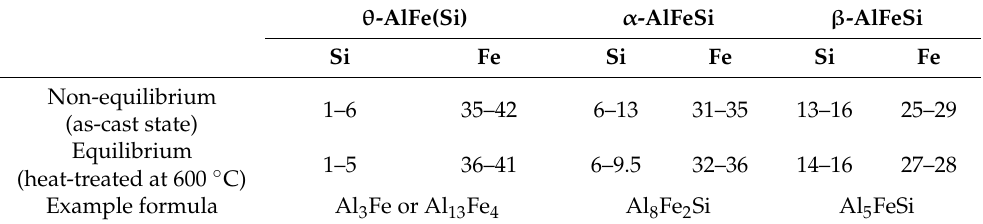
Table 1. Intermetallic phase concentration range (wt%) adapted from